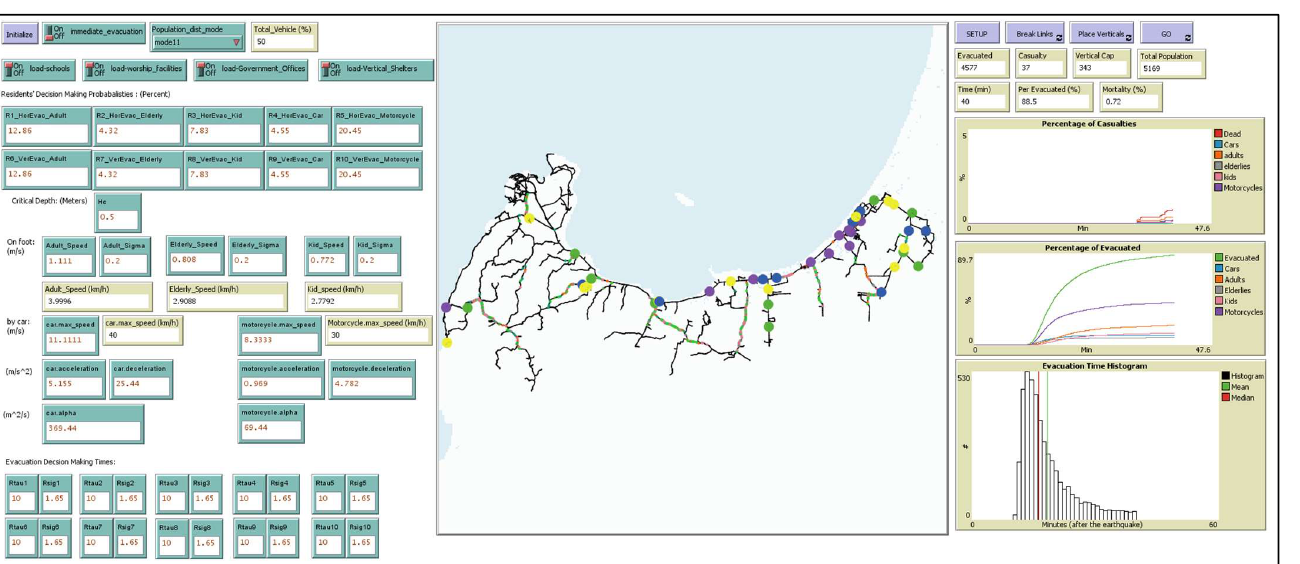
Figure 2. ABM modelling interface using NetLogo used for the tsunami evacuation process in the Panimbang subdistrict. Brown circles indicate the initial population (agents), schools in yellow, worship facilities in green, government offices in blue, and VESs in purple.